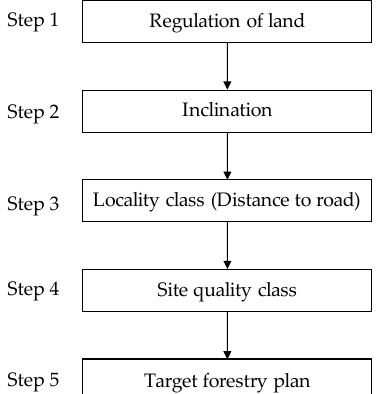
Figure 2. Zoning plan focused on wood production function.